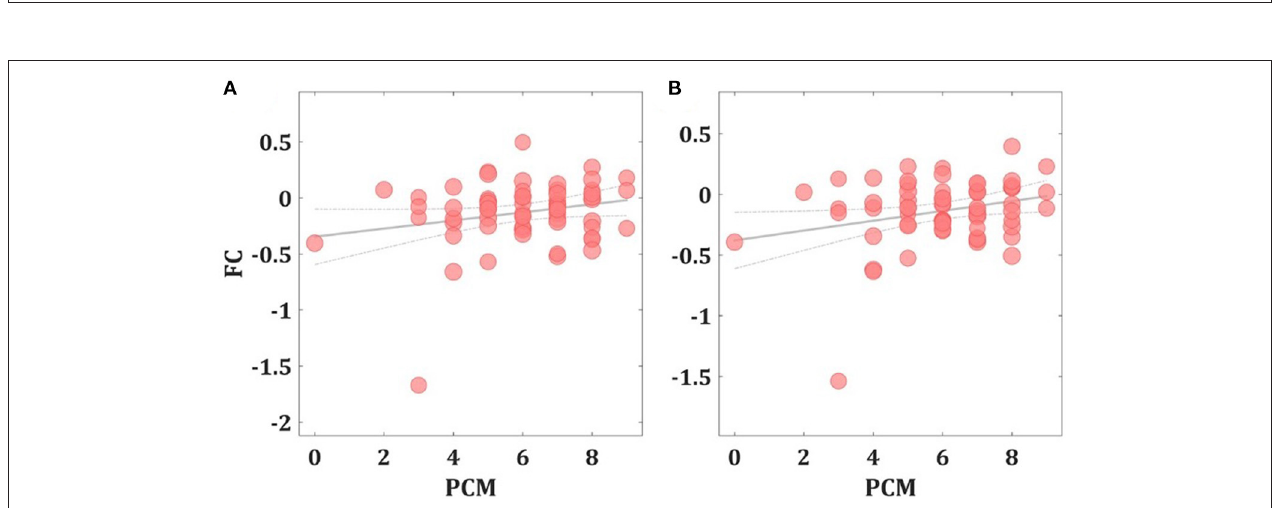
FIGURE 2 | Correlation between FC changes and PCM scores. Scatter plots showing the significant positive Pearson’s partial correlation coefficient ( r ) increases between the left amygdala FC seed region and the left precuneus (A) and the left superior parietal cortex (B) .